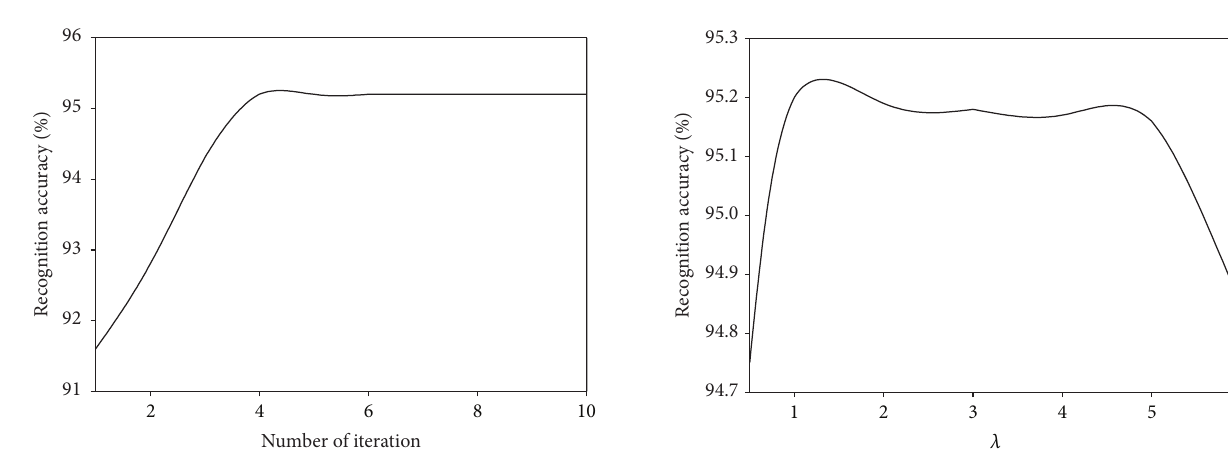
Figure 8: Recognition accuracy of MDGPP versus different num- bers of iteration on the CMU PIE database.